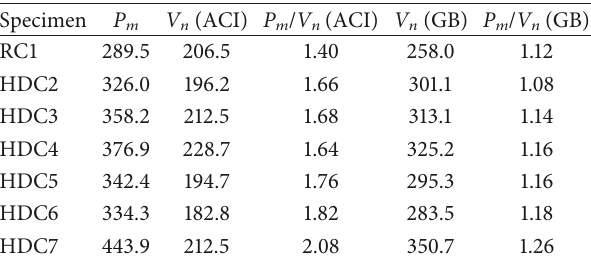
Table 7: Test results and calculated results